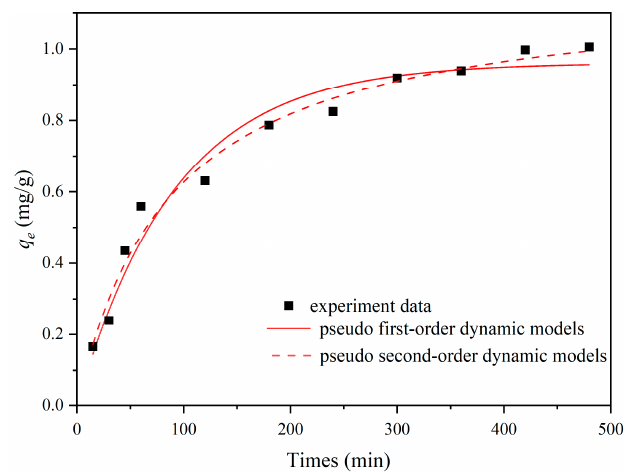
Figure 11. Quasi-first order, quasi-second order dynamic models for the ammonium adsorption on bio-ceramsite. Table 6. Kinetic parameters for pseudo first-order and pseudo-second-order dynamic models for the adsorption of ammonium on